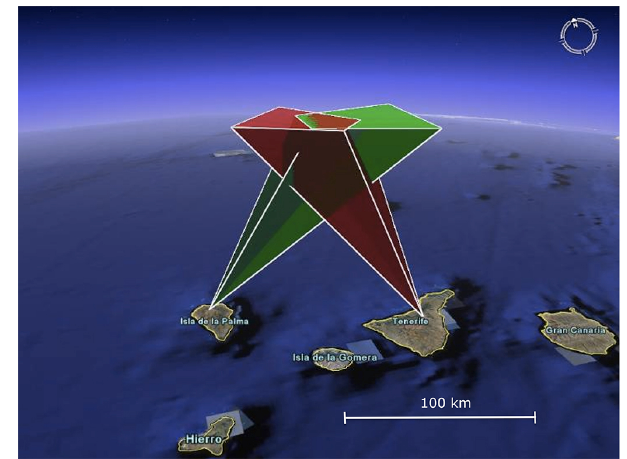
Fig. 1. Principle sketch of the CILBO camera set-up. Image: Google